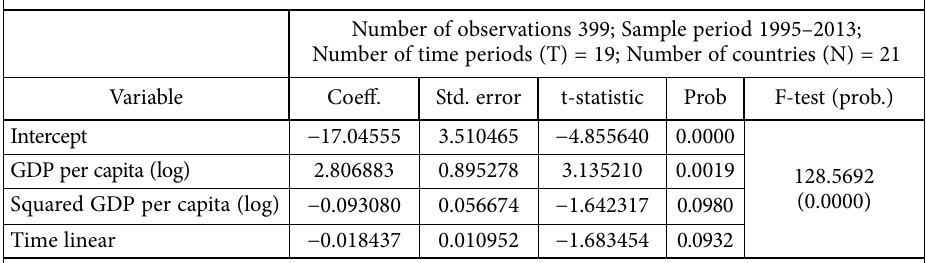
Table 1. Fixed effect regression Environmental protection and GDP in the European Union countries Dependent variable: logarithm of Environmental protection expenditure by central government